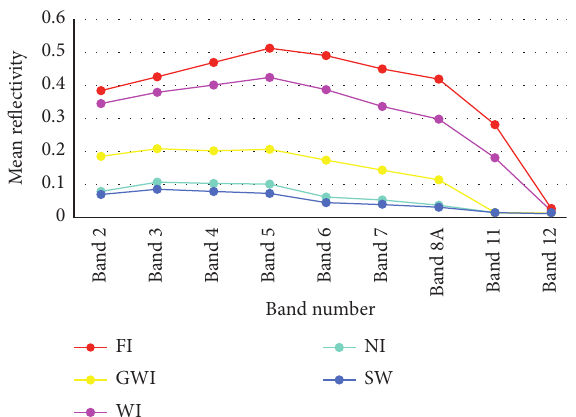
Figure 6: The mean reflectivity of different ice types in different bands of